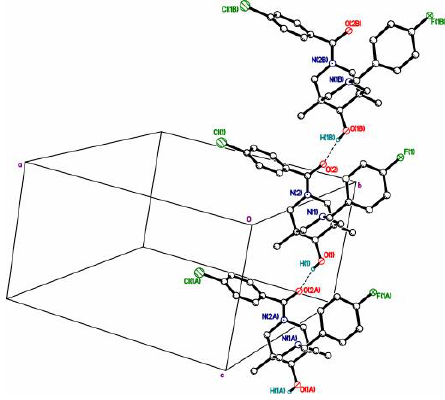
Figure 1. Hydrogen-bonded chains in structure 4cb .